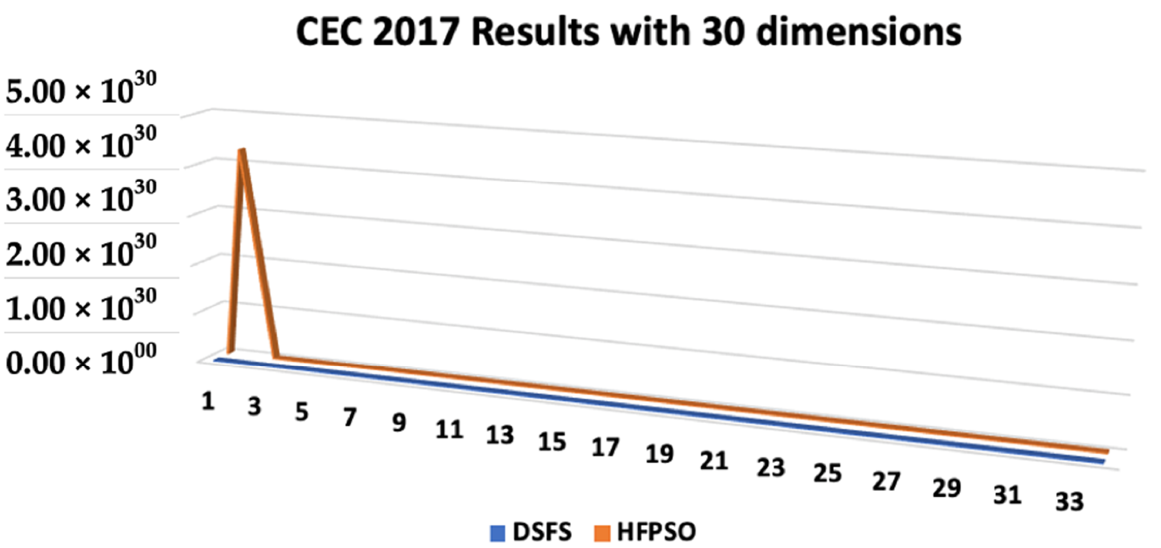
Figure 4. Results of the CEC 2017 with 30 dimensions. On the vertical axis, we can find the values obtained with the DSFS and HFPSO meth- ods, and the horizontal axis shows the corresponding functions. The DSFS approach, in- dicated by the blue line, has better efficiency than the HFPSO (orange line) because the values are closer to the global optima, as seen in Figure 3.